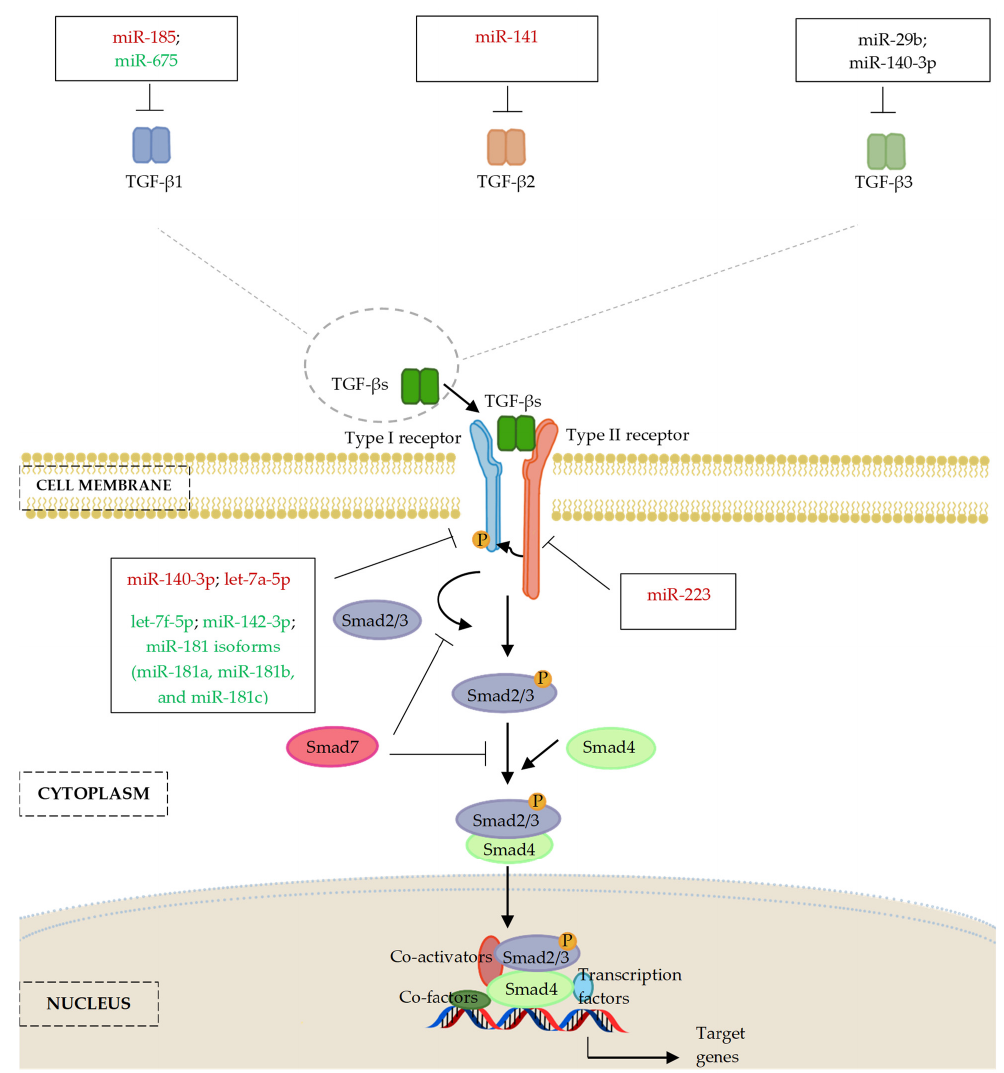
Figure 3. Schematic representation of microRNA-mediated regulation of the transforming growth factor- β (TGF- β ) signalling pathway. Notes: MicroRNAs in green implied positive regulation on osteogenesis, and microRNAs in red implied negative regulation on osteogenesis, while mi- croRNAs in black text indicate both positive and negative effects on osteogenesis.